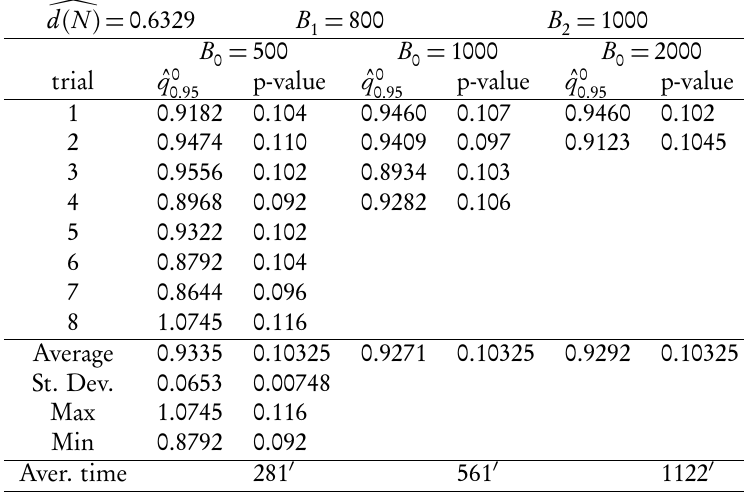
Tail properties of the predictive null distribution of d ( N )